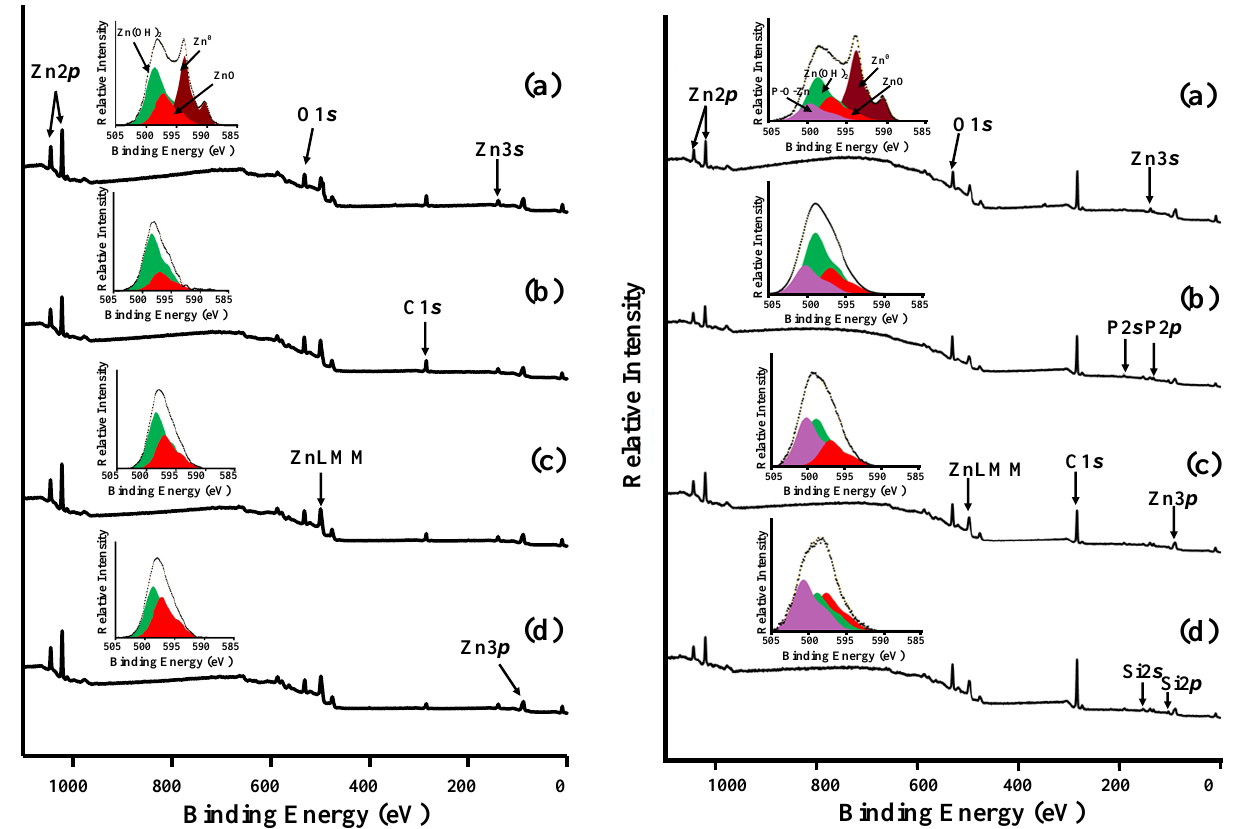
Figure 8. XPS survey spectra and Auger ZnL 3 M 45 M 45 spectra of zinc samples with different surface types before ( left ) and after ( right ) layer-by-layer treatment in solutions of 2.5 mM SDDP and 10.0 mM OTES: ( a )—Type 1, ( b )—Type 2, ( c )—Type 3, ( d )—Type 4.